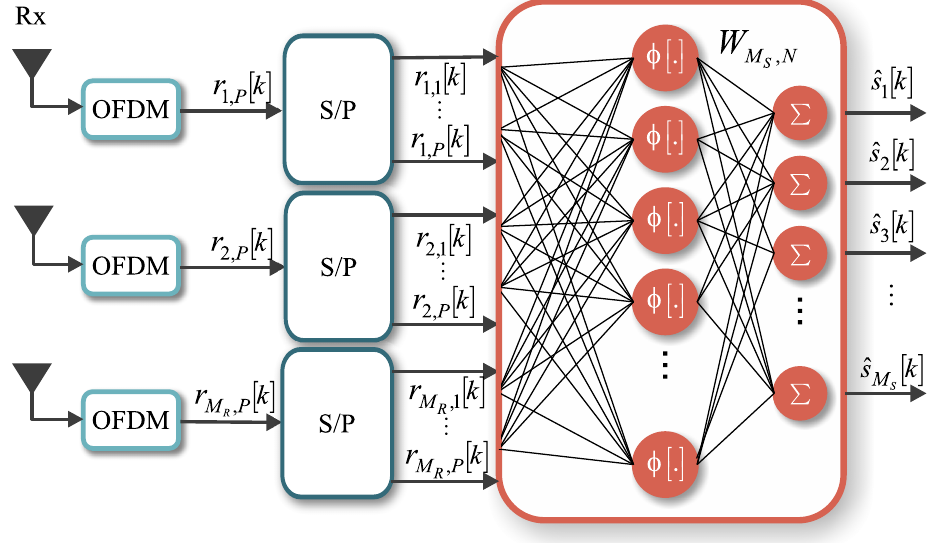
Figure 5. Closer view of the system with neural network decoding